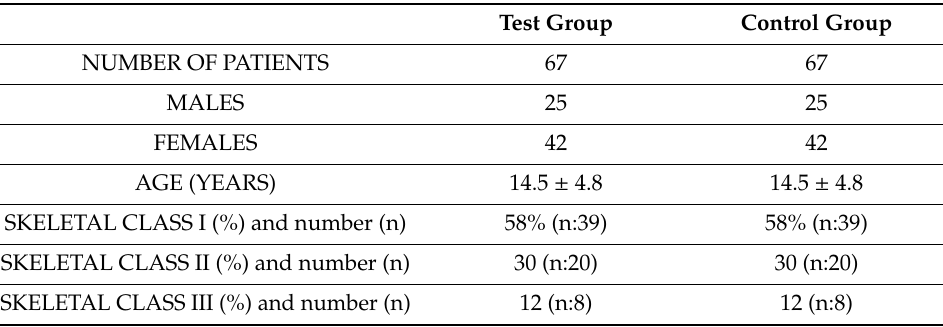
Table 1. Demographic information of the two groups.